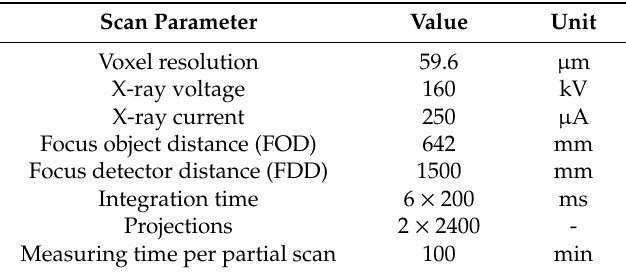
Figure 11. ( a ) Exemplary CT measurement setup (note: here, focus object distance (FOD) and the focus detector distance (FDD) are not the ones used for the scans); ( b ) schematic illustration of merged CT scans with overlap areas. Table 5. Micro-CT measurement